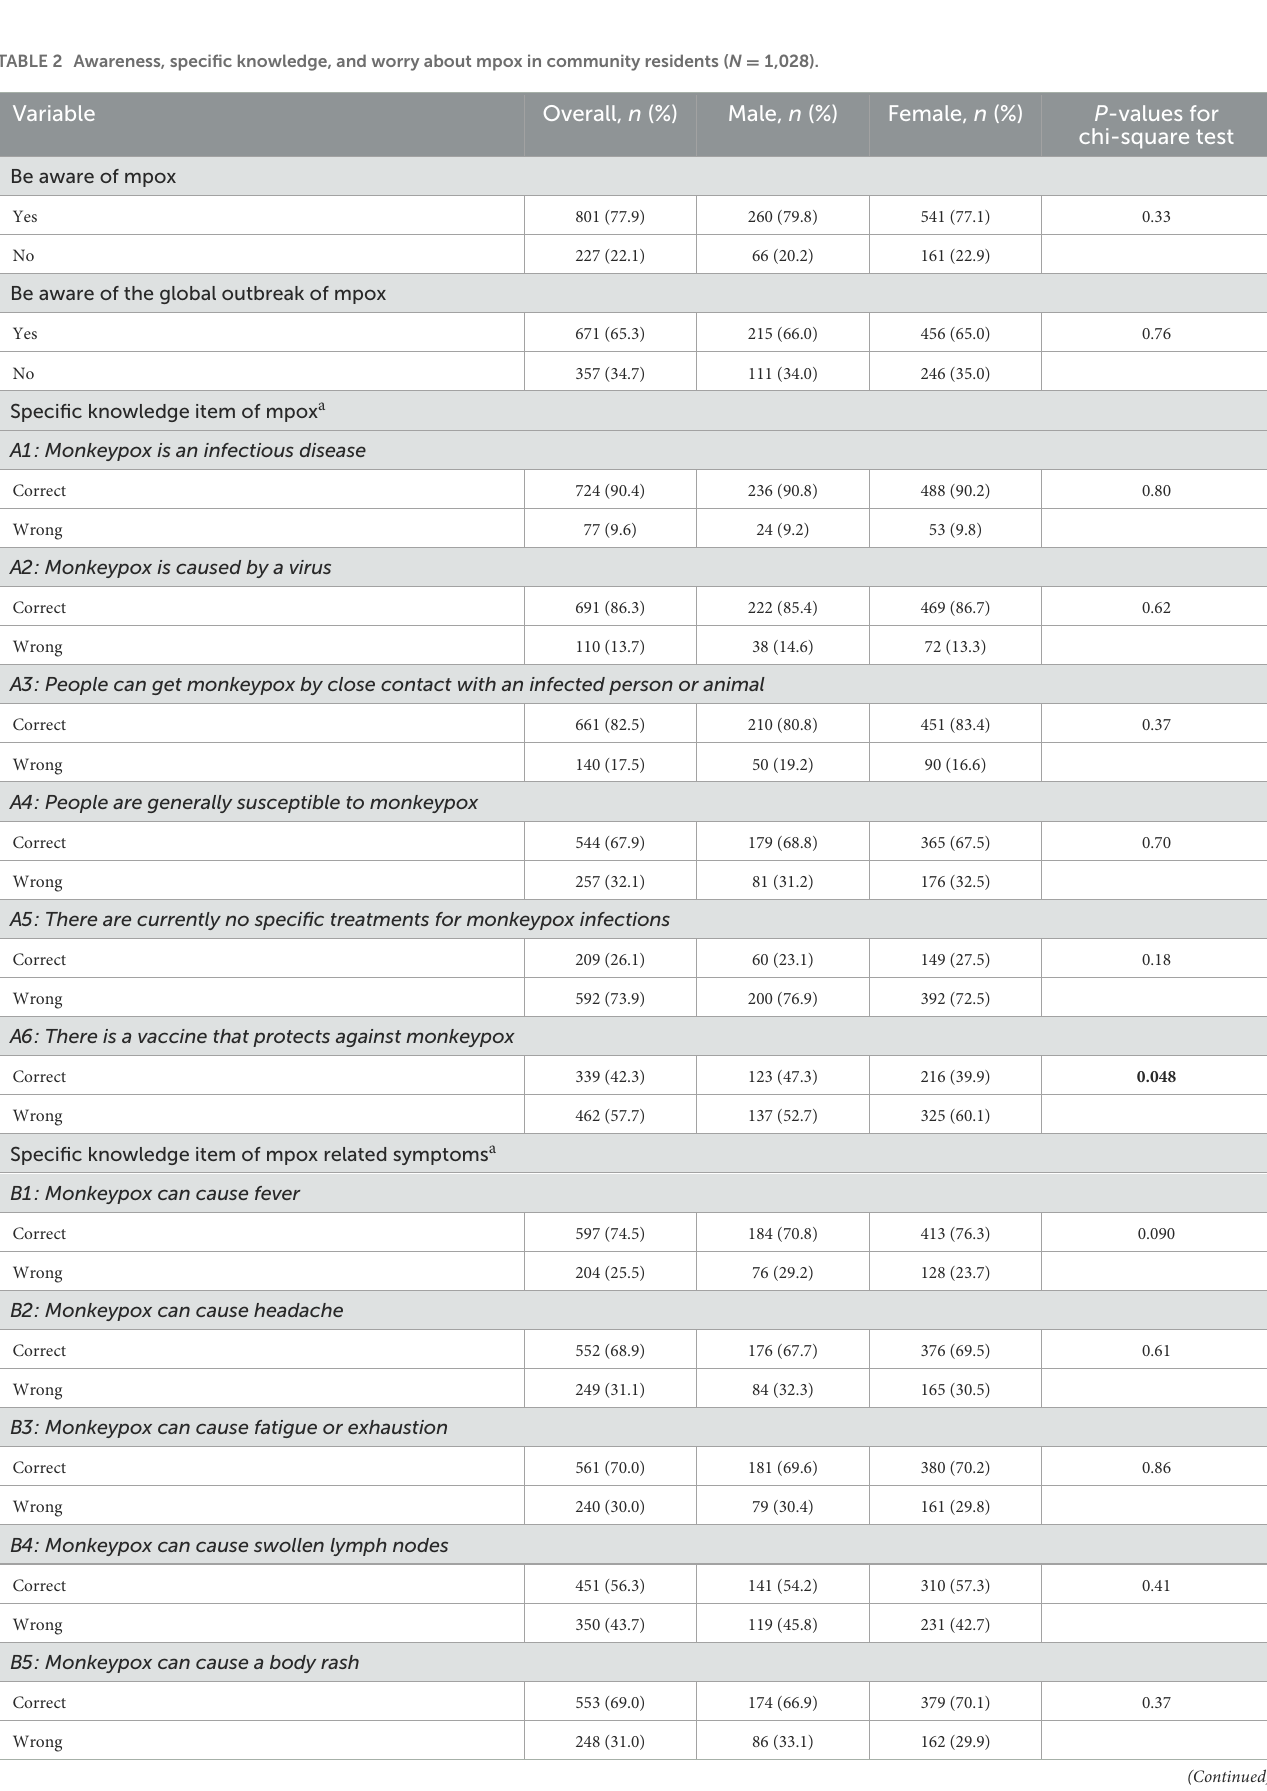
TABLE 2 Awareness, specific knowledge, and worry about mpox in community residents ( N = 1,028). Variable P -values for